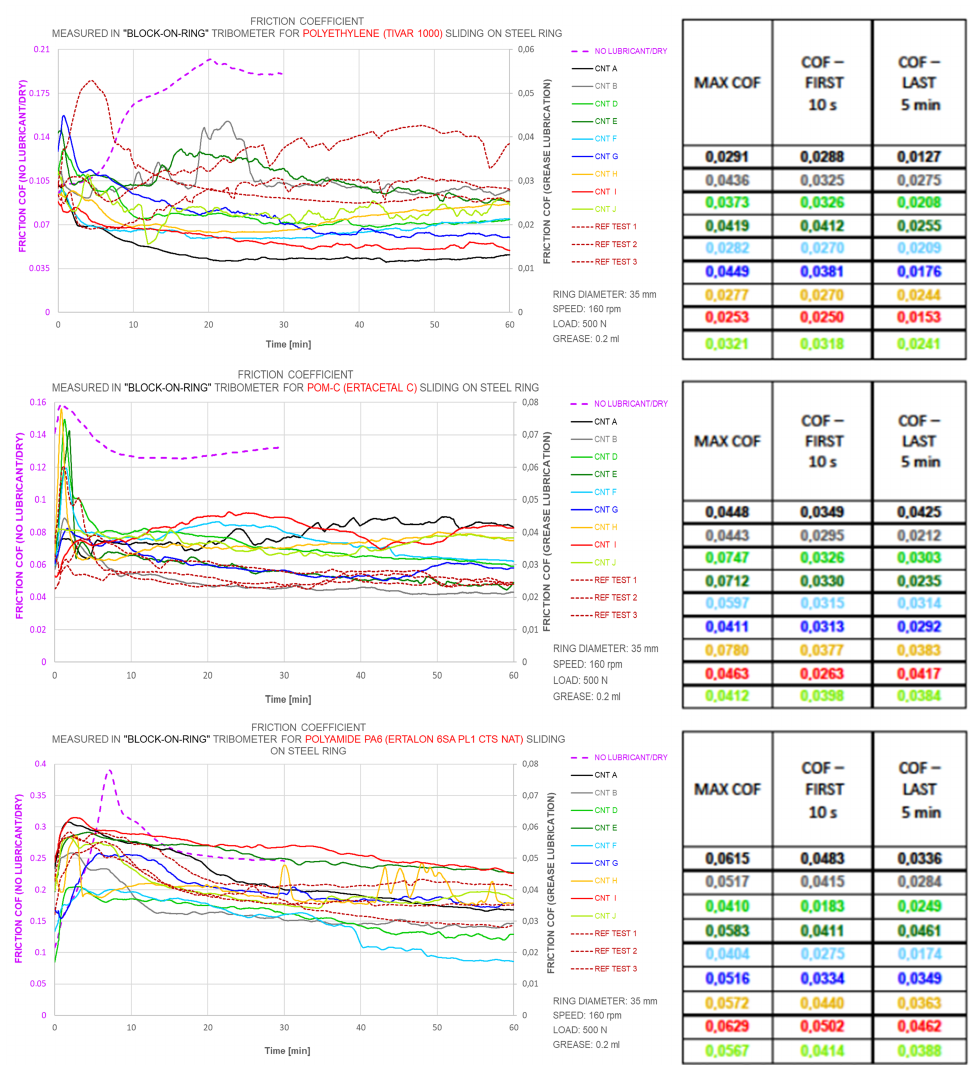
Figure 6. COF measured in a “block-on-ring” tribometer for various polymers sliding on a steel ring; graphs and corresponding COF values for polyethylene, polyoxymethylene, and polyamide. Comparison of CNT friction-reducing potential tests conducted for various CNT types added to the reference lithium grease in a mass concentration as low as 0.01% (COF—first 10 s and COF—last 5 min calculated as a mean